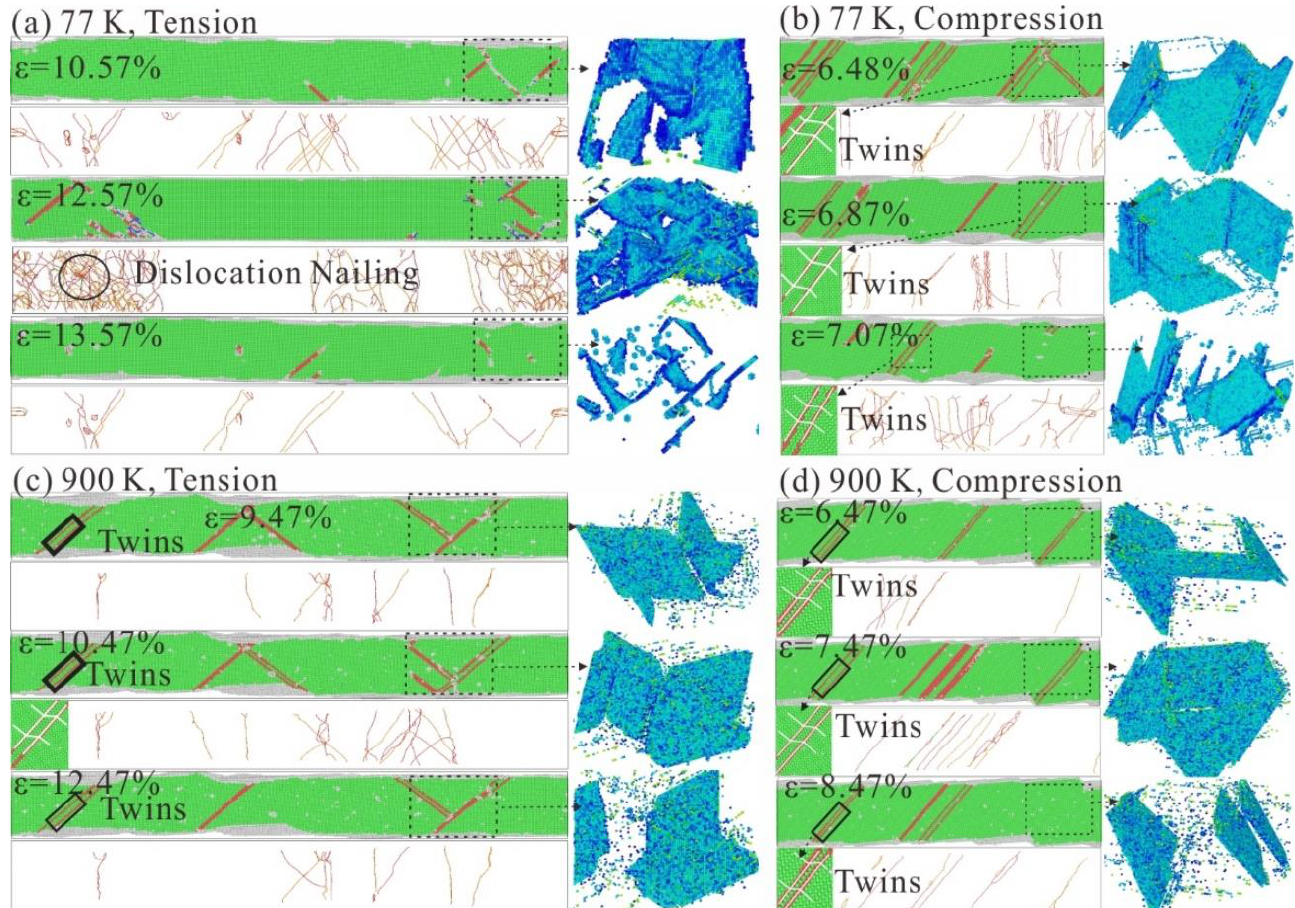
Figure 6. Microstructural evolution of FeNiCrCoCu HEAs with unequal atomic ratio under tensile and compressive loads at different temperatures. ( a ) can, DXA and dislocation microstructure diagram at 77 K with strain of 10.57%, 12.57% and 13.57%; ( b ) canCNA, DXA and dislocation microstructure diagram at 77 K with compressive strain of 6.48%, 6.87% and 7.07%; ( c ) CNA, DXA and dislocation microstructure diagram at 900 K with strain of 9.47%, 10.47% and 12.47%; ( d ) CNA, DXA and dislocation microstructure diagram at 900 K with compressive strain of 6.47%, 7.47% and 8.47%.